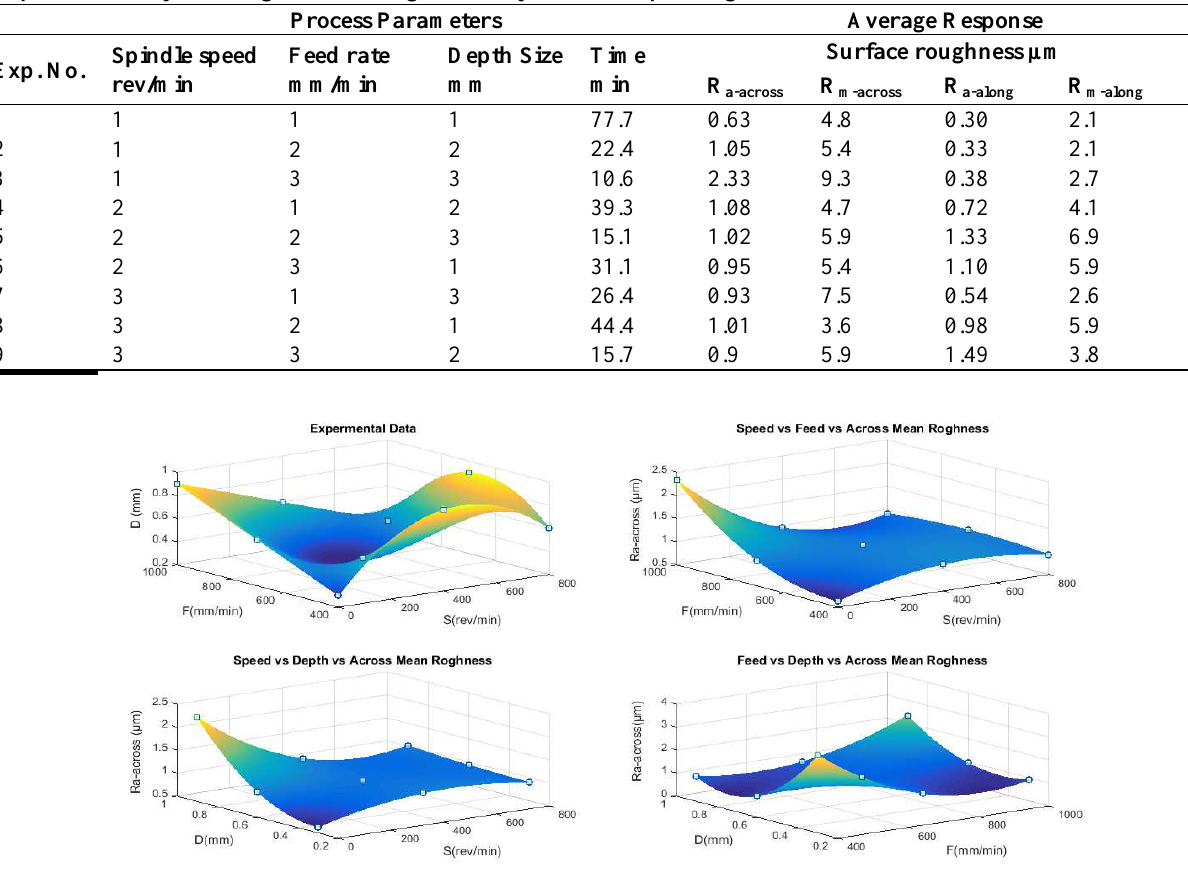
Fig. 5. The relationship of mean roughness (across) with respect to process